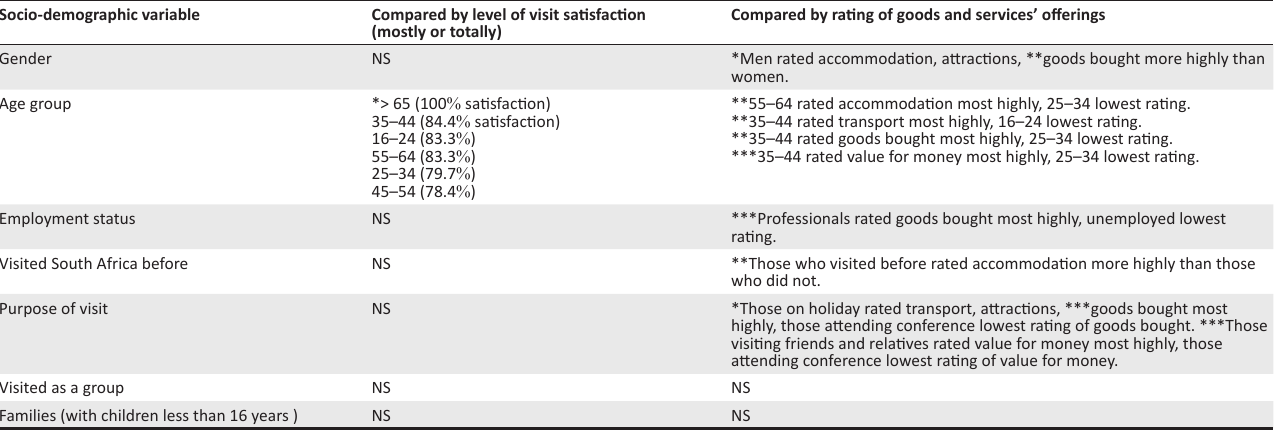
TABLE 3: Sociodemographic characteristics of the respondents versus level of visit satisfaction and rating of goods and services ( n = 313). Socio-demographic variable Compared by level of visit satisfaction (mostly or